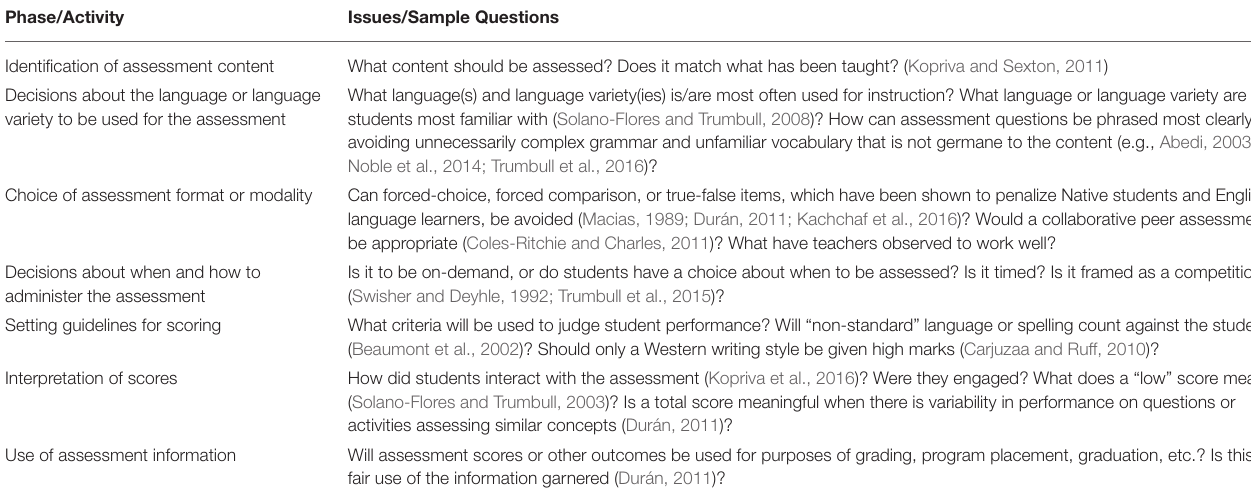
TABLE 1 | Some elements of a process for promoting cultural validity in